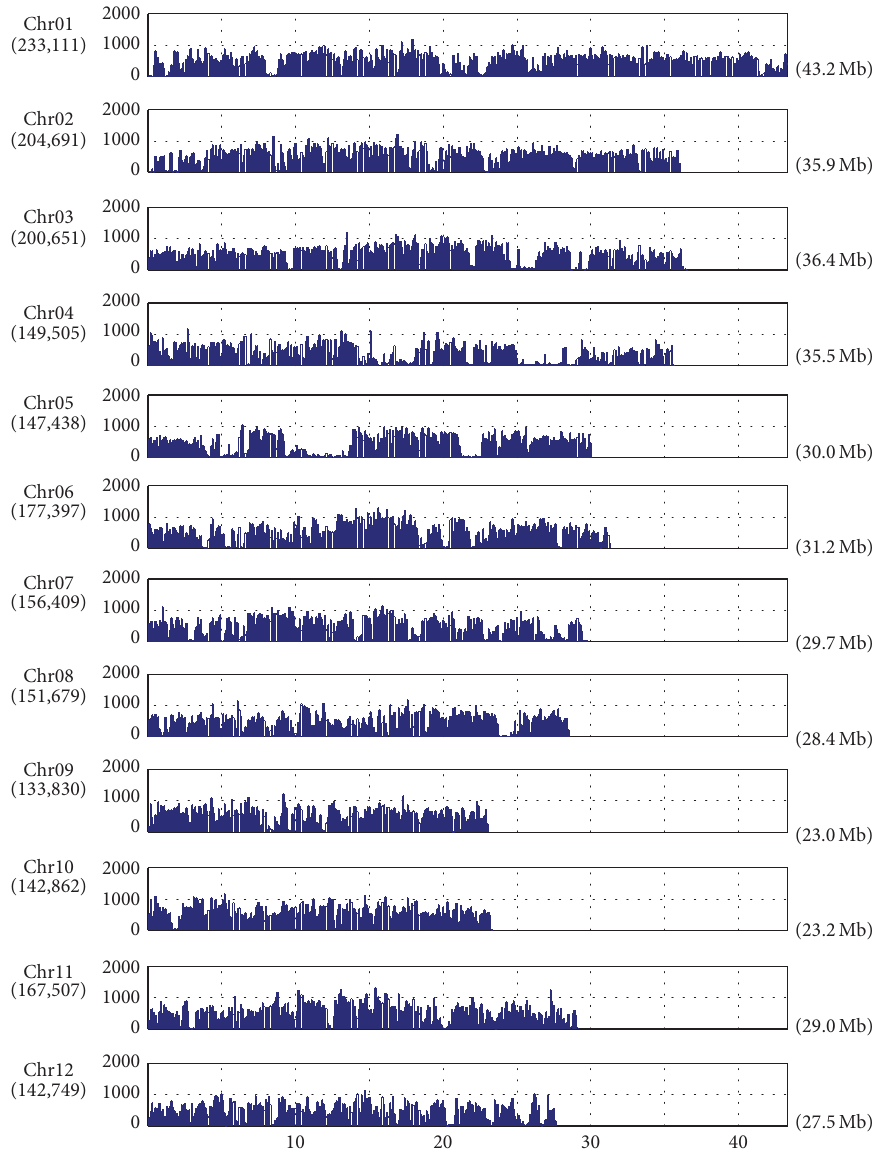
Figure 2: Distribution of SNPs between indica 12 and Nipponbare on the 12 chromosomes. The 𝑥 -axis shows the physical distance of chromosome into 100 kb windows. The chromosome size is indicated in brackets. The 𝑦 -axis represents the number of SNPs per 100 kb. The total of SNPs in each chromosome is shown in